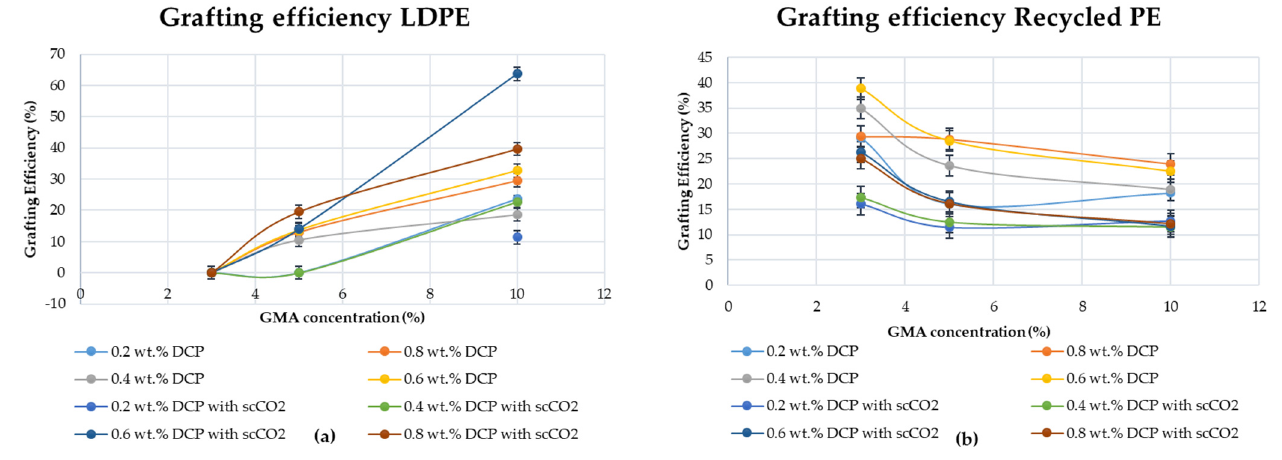
Figure 5. Grafting efficiencies for LDPE ( a ) and RPE ( b ).